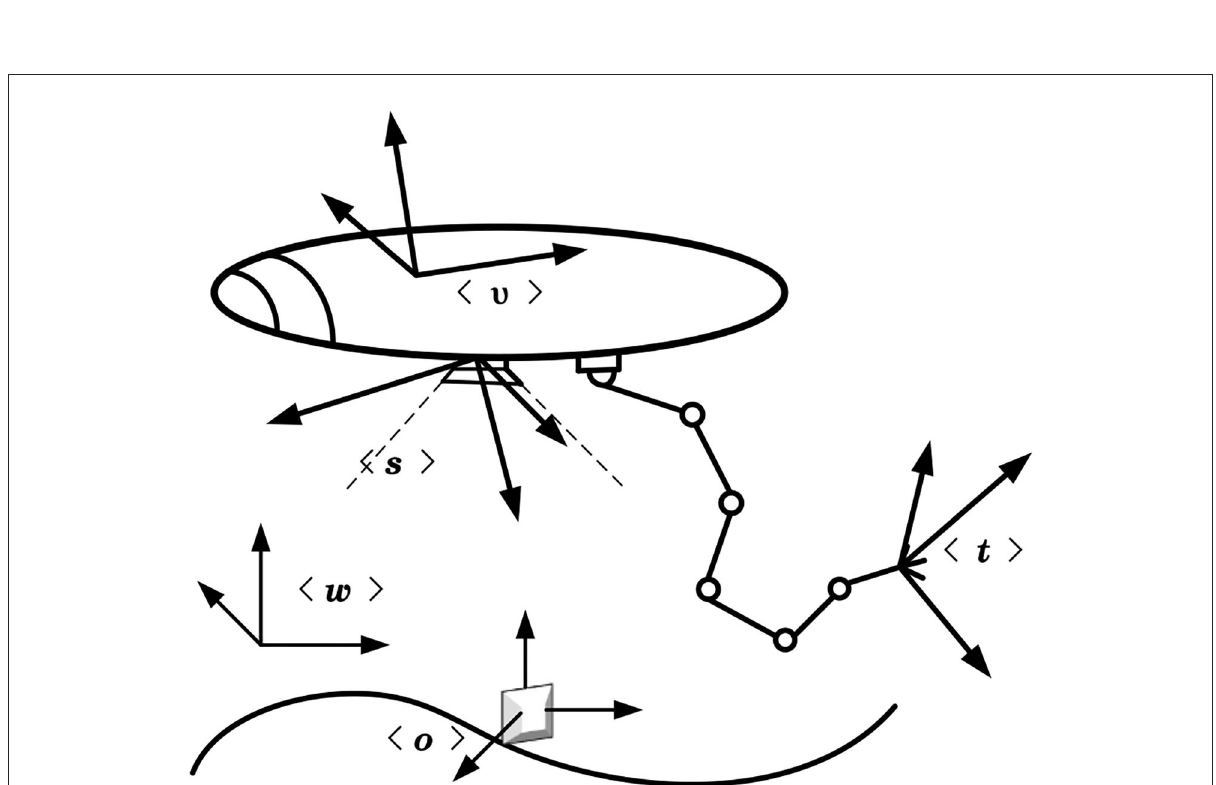
FIGURE2 The UVMS and its relevant